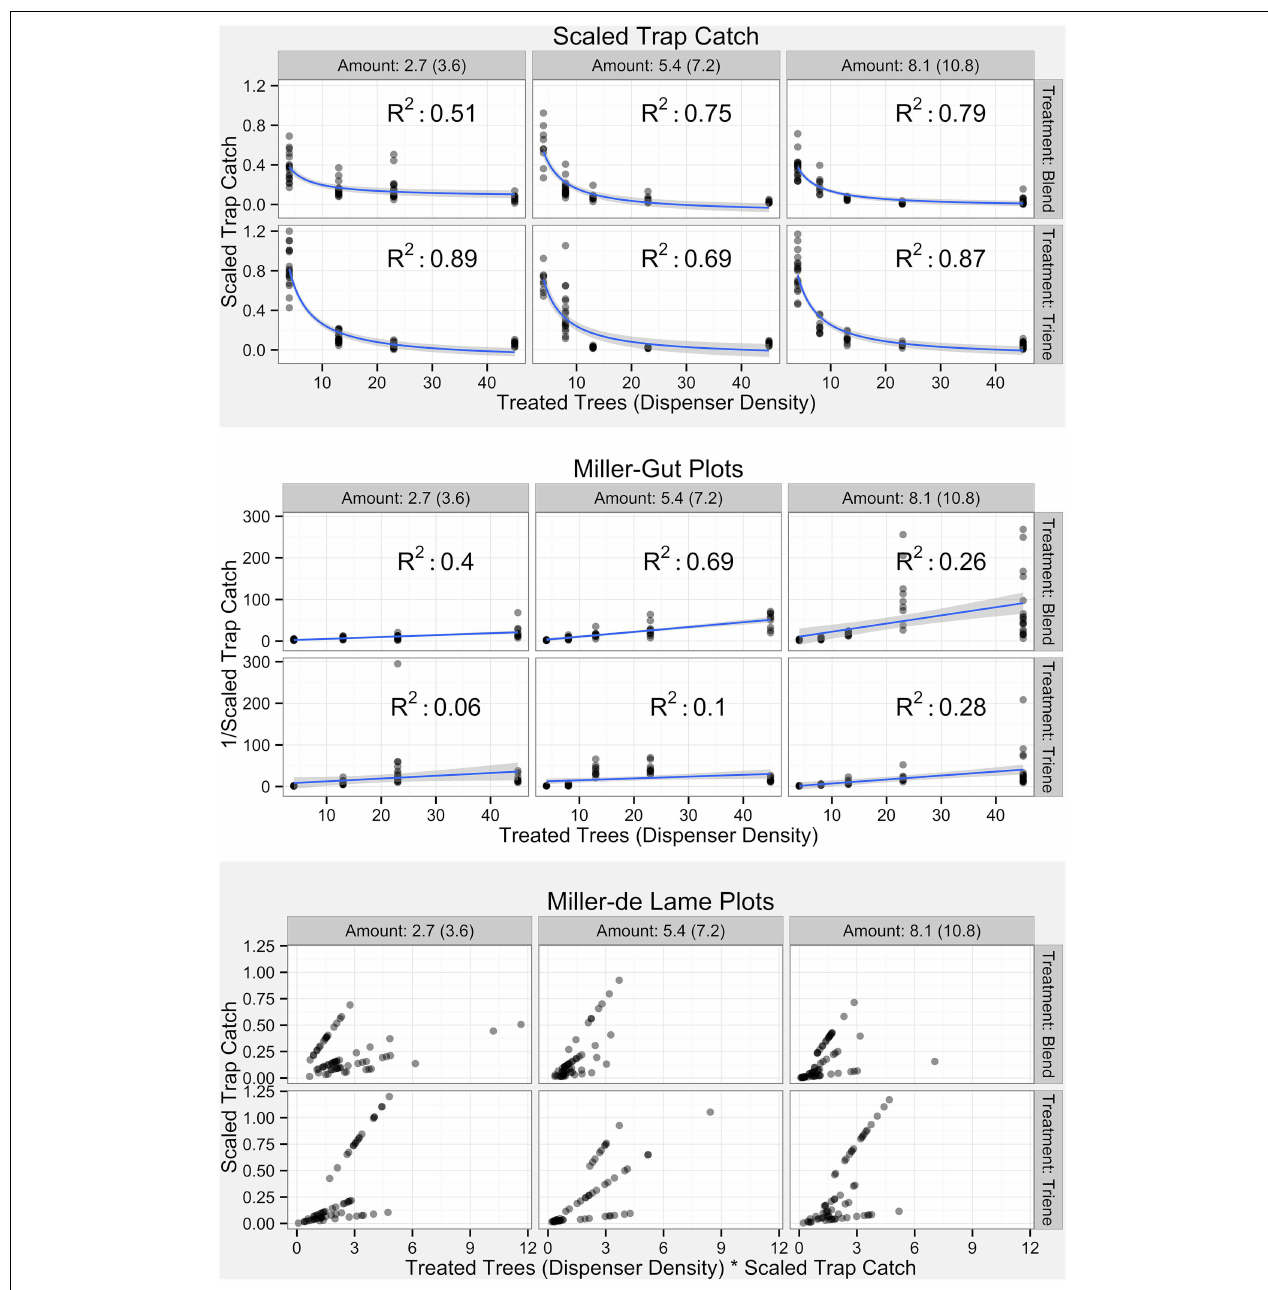
FIGURE 5 | Field Diagnostic Plots by treatment and in accordance with diagnostic plots from Miller et al. (2006a). Transparent points indicate specific observations; more opaque points indicate overlap of many points. Blue lines and shaded gray areas in the untransformed plots (top shaded panel) indicate a model fit where